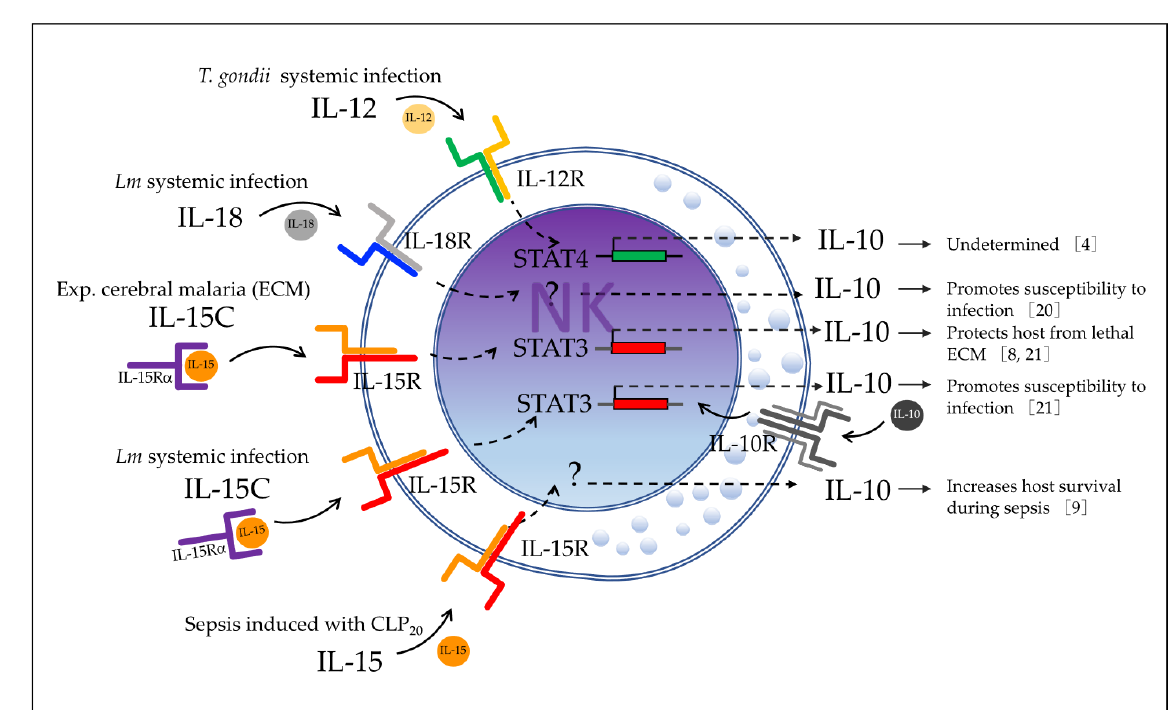
Figure 7. Cytokines and transcription factors that regulate IL-10 production by NK cells in models of systemic infection. Shown are the cytokines and transcription factors associated with induction of IL-10 by NK cells and the effect on the host immunity in the models of T. gondii infection, Lm infection, ECM, and sepsis induced with CLP 20 . T. gondii — Toxoplasma gondii ; Lm — Listeria monocytogenes; IL-15C — IL-15 and IL15Ra complex treatment; ECM — experimental cerebral malaria; CLP 20 — cecal ligation and puncture with 1 puncture.